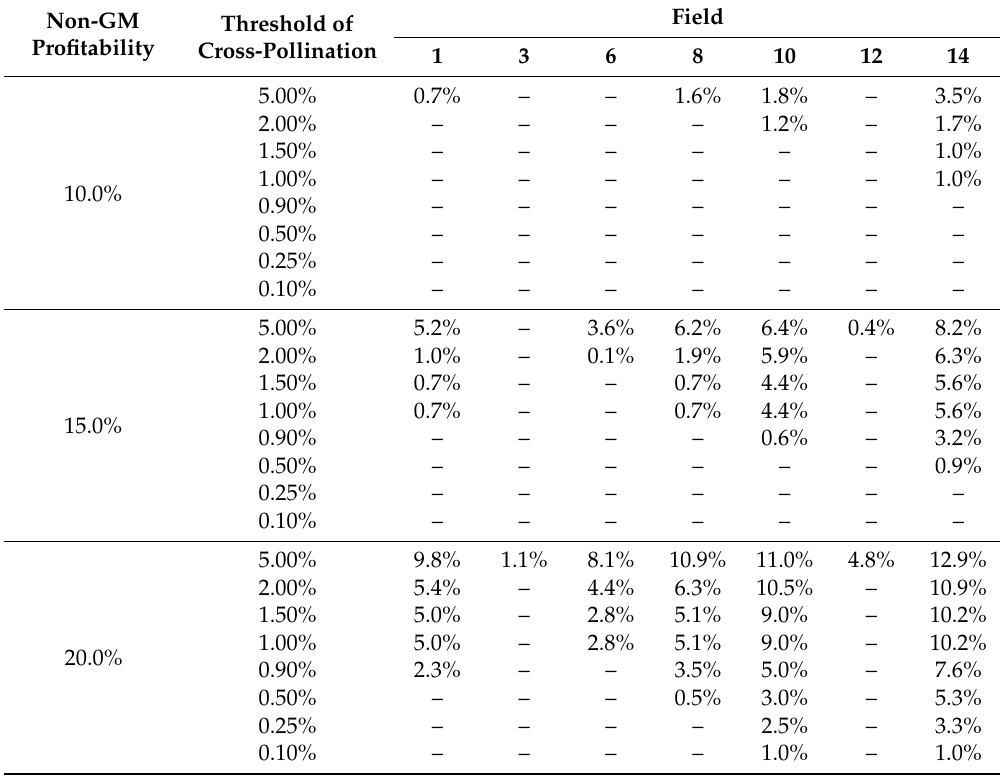
Table 5. Percentage profits relative to the baseline non-GM crop profits at the field level as a function of increasing profitability for the non-GM crop in comparison to the GM crop and thresholds of cross-pollination when GM producers have the property rights. There is heterogeneity in the profits of non-GM fields because heterogeneous amounts of buffer are created in the non-GM fields. The non-GM fields include 1, 3, 6, 8, 10, 12, and 14. The economic unsuitability of a field for the non-GM crop (i.e., losses due to the buffer) is represented by dashes in the